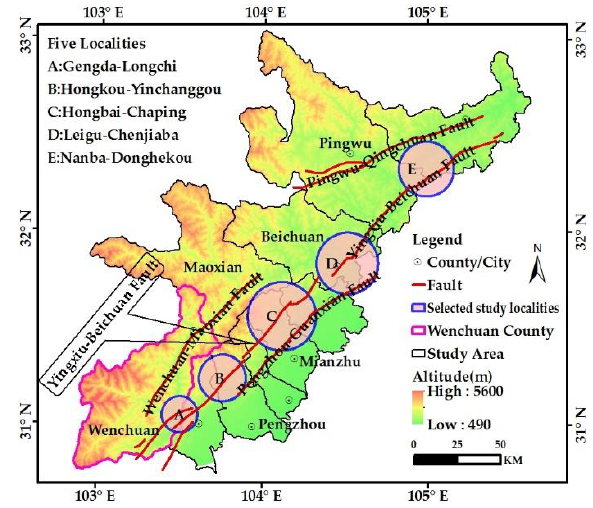
Figure 1. DEM (Digital Elevation Model) of the study area in Sichuan Province, China. The black polygon represents the study area; the area delineated by the magenta line represents Wenchuan County; the pink circles labelled A–E are the five studied localities; the red lines are faults. The small dotted circles are County/City locations. The five key studied localities are as follows, A: Gengda (Wenchuan County)-Longchi (Dujiangyan City) locality; B: Hongkou (Dujiangyan City)-Yinchanggou (Pengzhou City) locality; C: Hongbai (Shifang City)-Chaping (Anxian County) locality; D: Leigu (Beichuan County)-Chenjiaba (Beichuan County) locality; E: Nanba (Pingwu County)-Donghekou (Qingchuan County) locality.